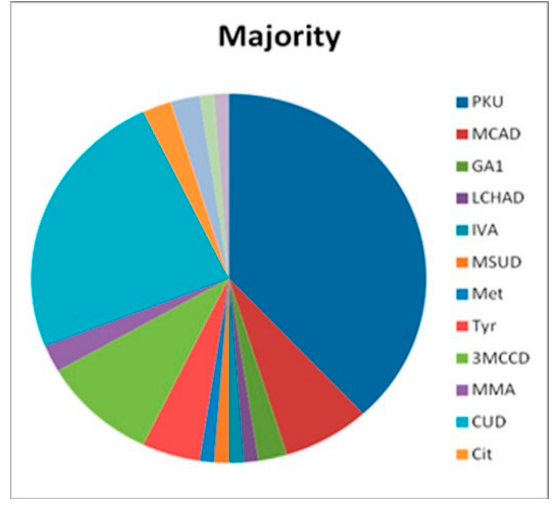
Figure 1. Spectrum of IEMs in the majority newborns.